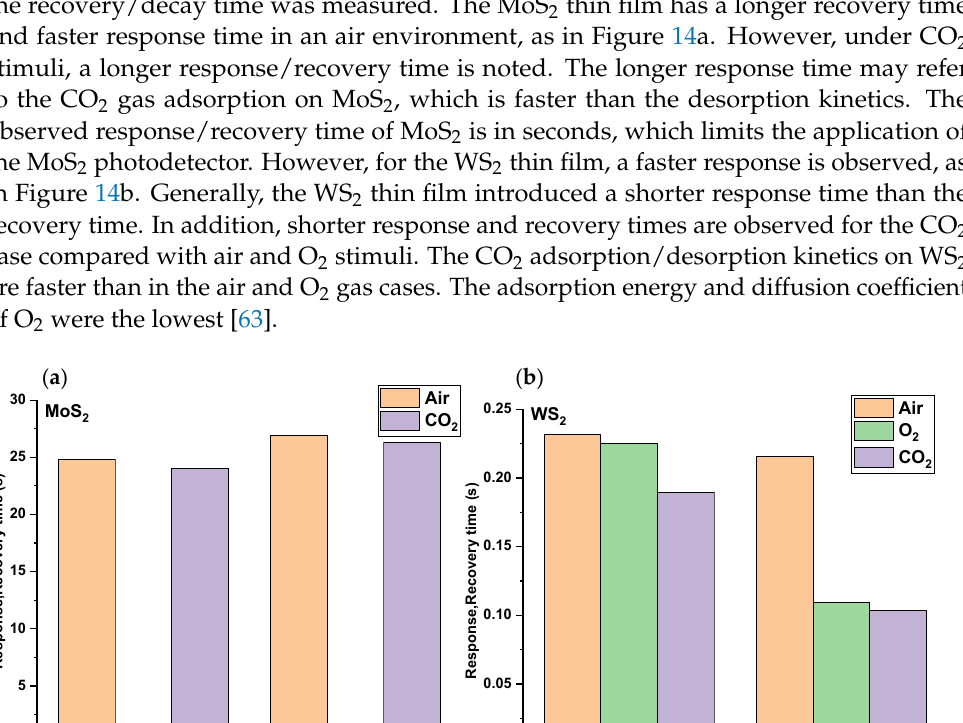
Generally, the WS 2 thin film introduced a shorter response time than the recovery time.